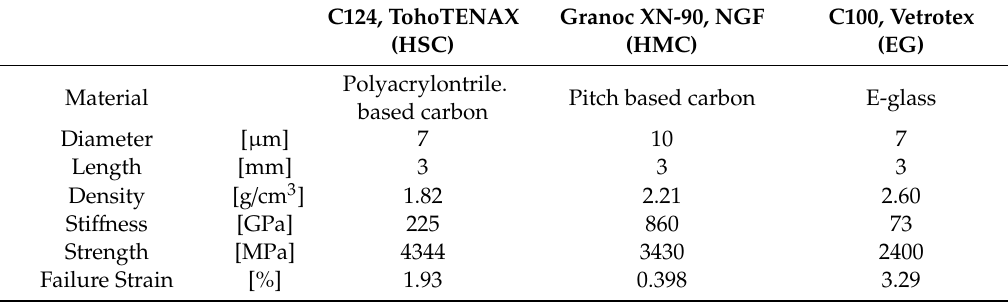
Table 1. Fibre Properties [4].